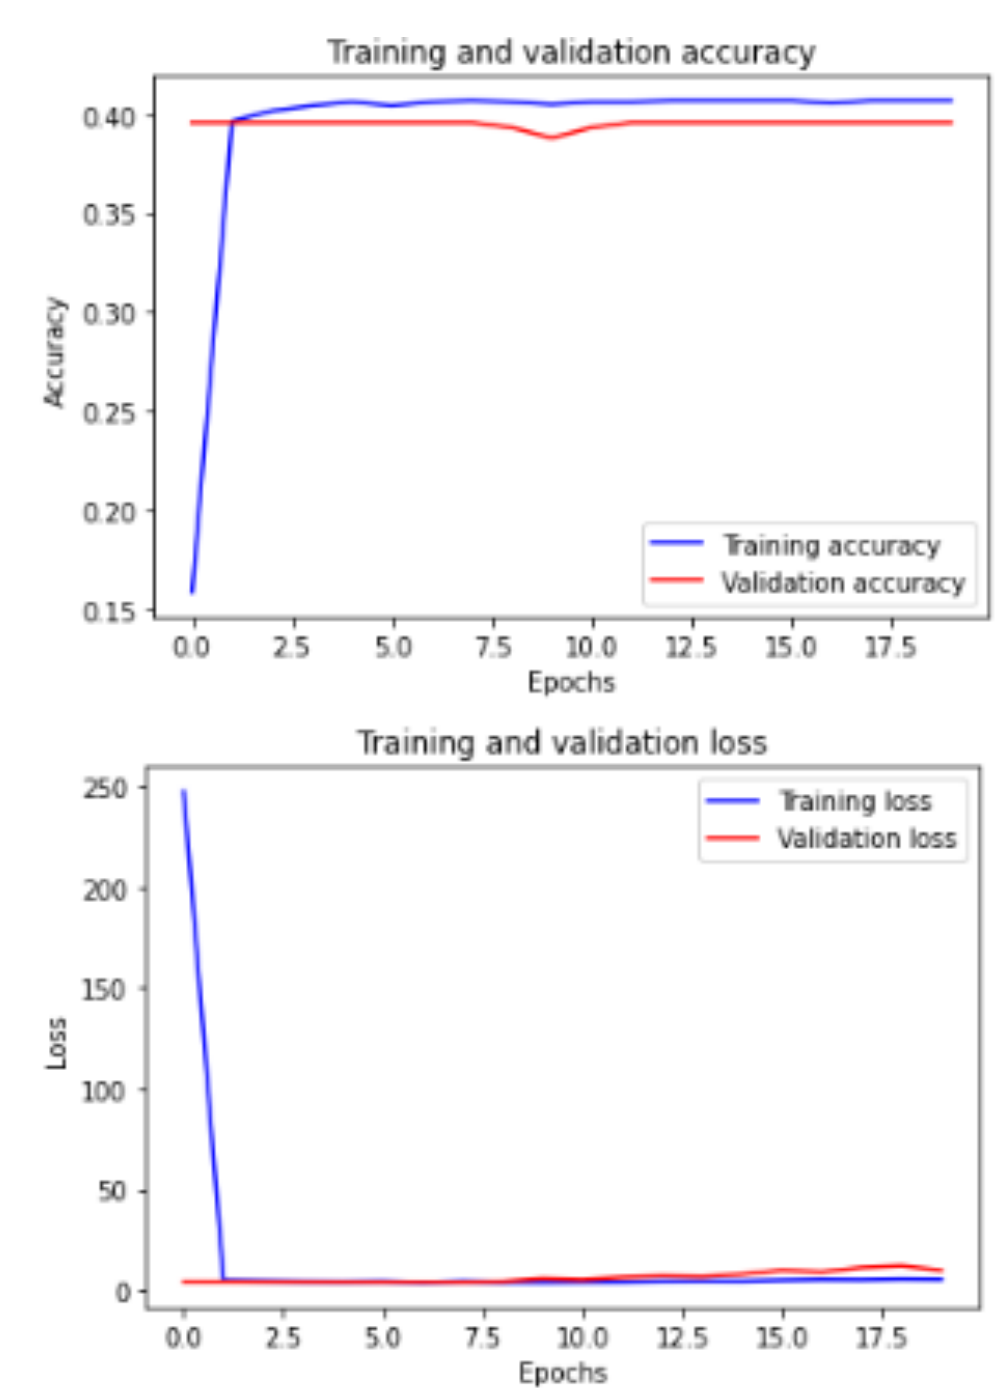
Figure 14. The training and validation ACC and loss through 50 epochs of the seResNext